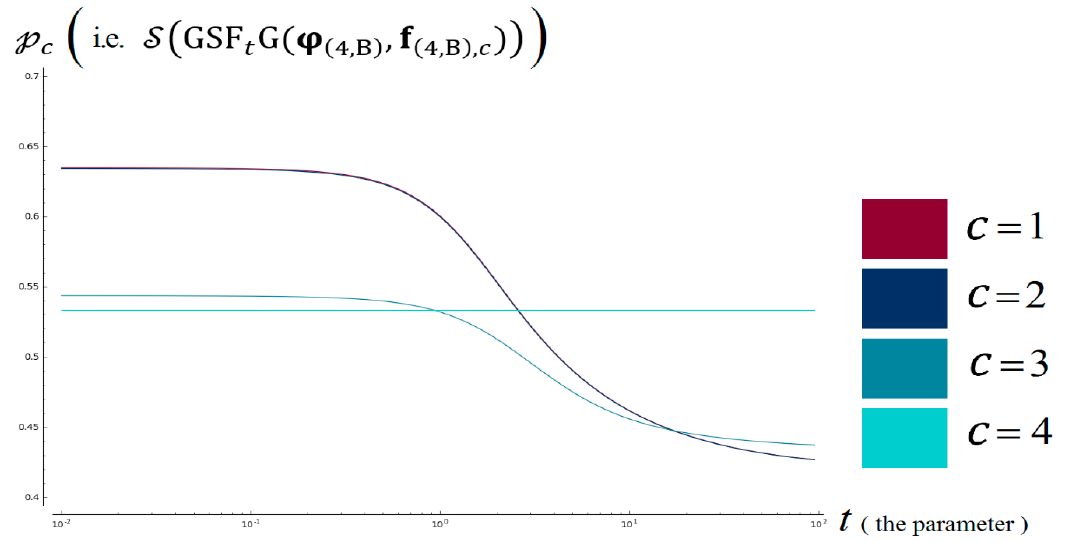
Figure 8. The results of our algorithms GSF 𝑡 A and GSF 𝑡 A for compliance of t-dependence test of type-B